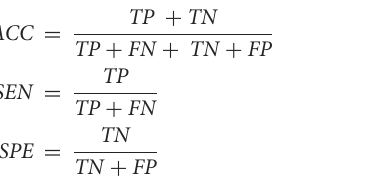
curve (AUC) to measure the performance of the